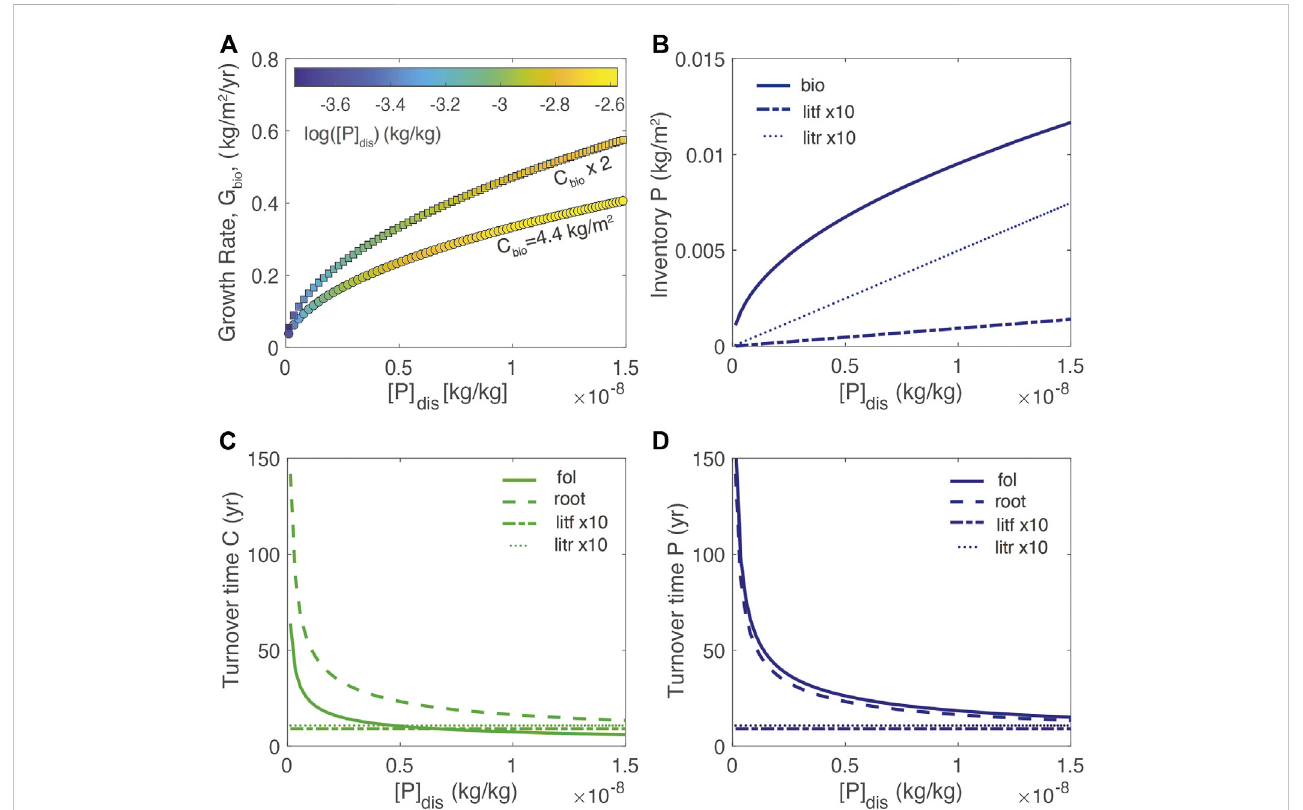
FIGURE 2 (A) Growth rate at different values of [P] dis for two different values of total biomass, C bio . The color-scale shows [P] fol ; (B) inventory of P in root and foliar biomassandlitter (C) dependenceofturnovertimeofbiomasscarboninthefoliage,root,andlitterreservoirson [P] dis ; (D) dependenceofturnovertimeofPin thefoliage,root,andlitterreservoirson [P] dis .Turnovertimeiscalculatedasthequotientoftheinventoryofnutrientinaparticularreservoir,dividedbythe fl ux of nutrient out of the reservoir. See Table 1 for additional parameter